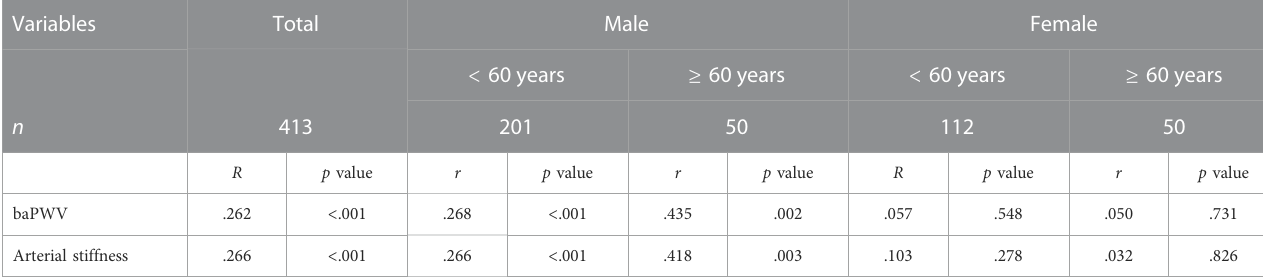
TABLE 3 Relationships between the FAR and baPWV, the FAR and arterial